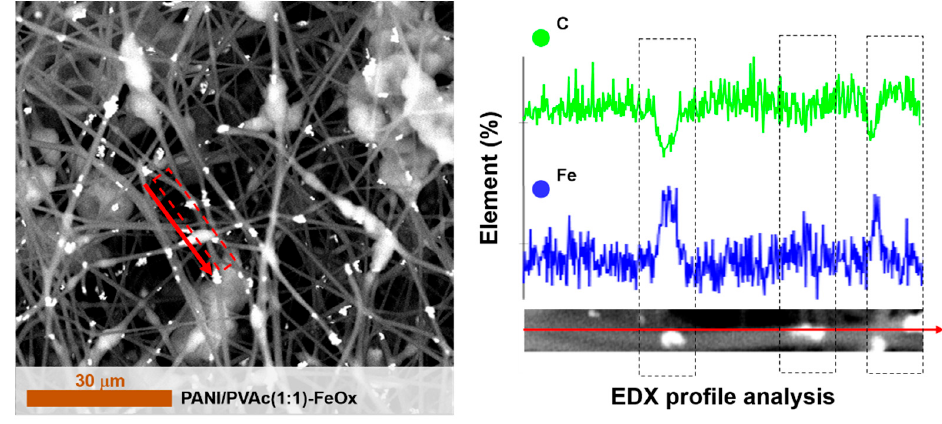
Figure 8. SEM images of PANI/PVAc (1:1)-FeO x and delimited EDX profiles .